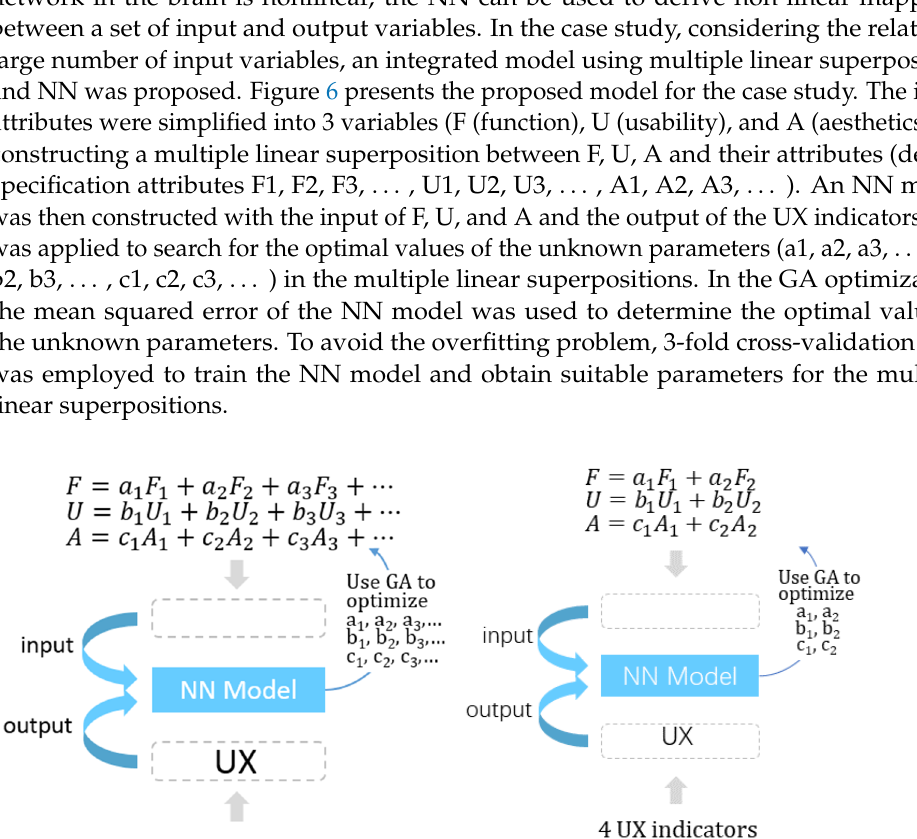
Figure 7. Optimized parameters of multiple linear superposition. 4.4. Mapping Model Implementation In the case study, two scenarios for implementing the mapping model were pre ‐ sented. The first scenario was to select camera design specifications among three design specification candidates that were proposed by the design team. Table 3 presents the val ‐ ues of the three design specification candidates for selection. From the mapping model, the corresponding UX indicators were predicted and illustrated in Figure 8. Among the 0.740 0.168